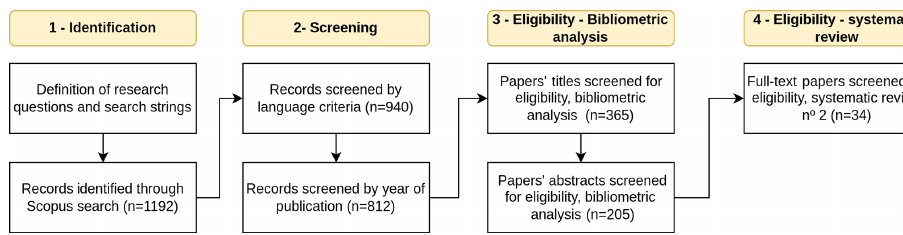
Figure 1. Methodological steps of the PRISMA statement.